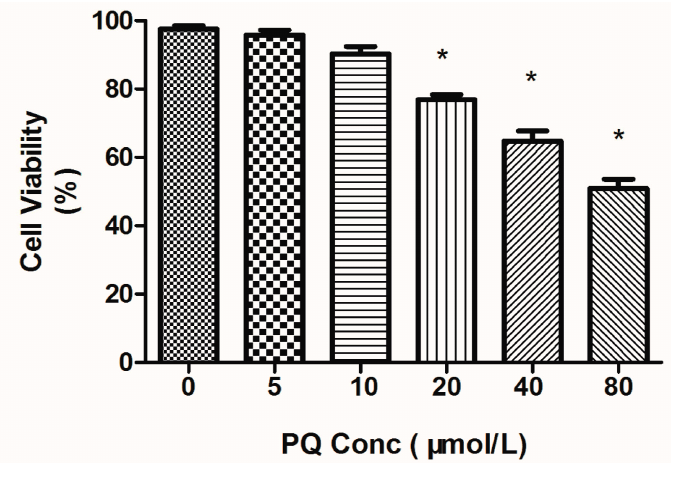
Figure 1. Paraquat (PQ)-induced dose-dependent decrease of cell viability in human nNeural progenitor cells (hNPCs). hNPCs were treated with PQ for 24 h and cell viability was measured by quantitative alamar blue assay. * Indicate statistically significantly lower than that in the control ( p < 0.05). n = 3 independent biological replicates for alamar blue